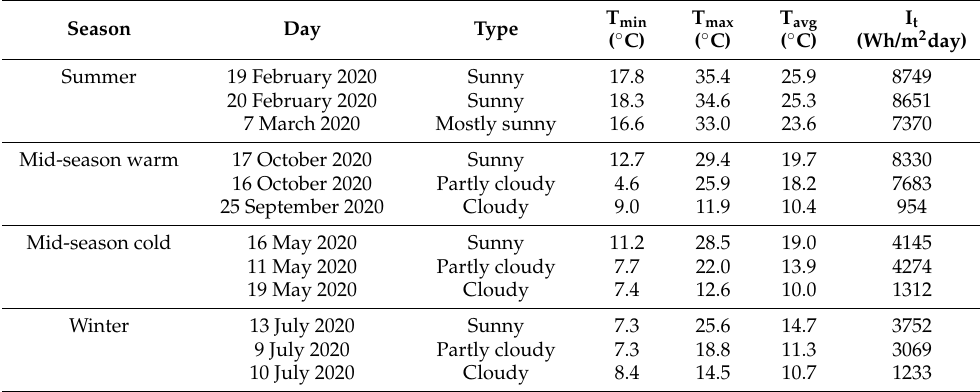
Table 3. Representative days for each season.